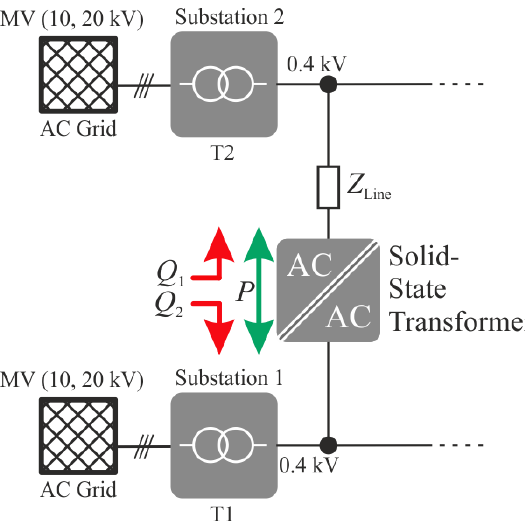
Figure 1. Exemplary grid topology with the SST used for grid reinforcement in addition to the distribution